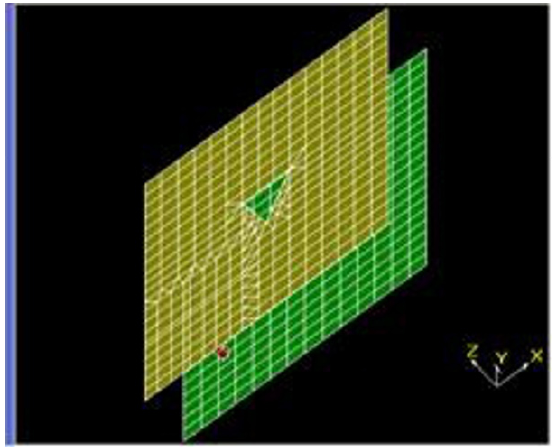
Figure 8. 3D structure of slotted microstrip